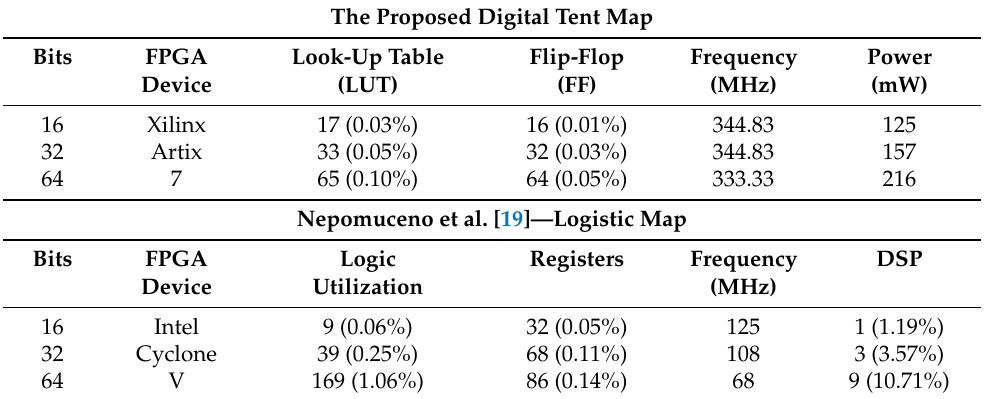
Table 2. List of components used in the digital representation of the tent map with different resolu- tions, in comparison with the proposed design using the logistic map in [19]. The Proposed Digital Tent Map